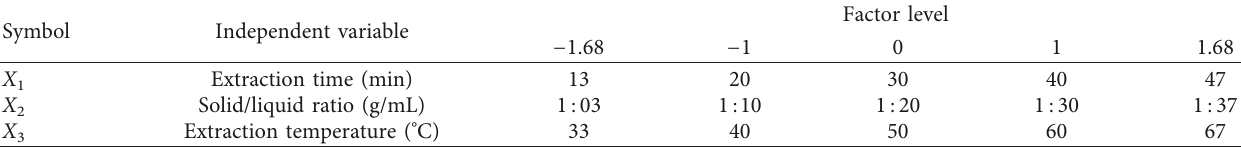
Table 1: Independent variables and their levels in central composite circumscribed (CCC) design.